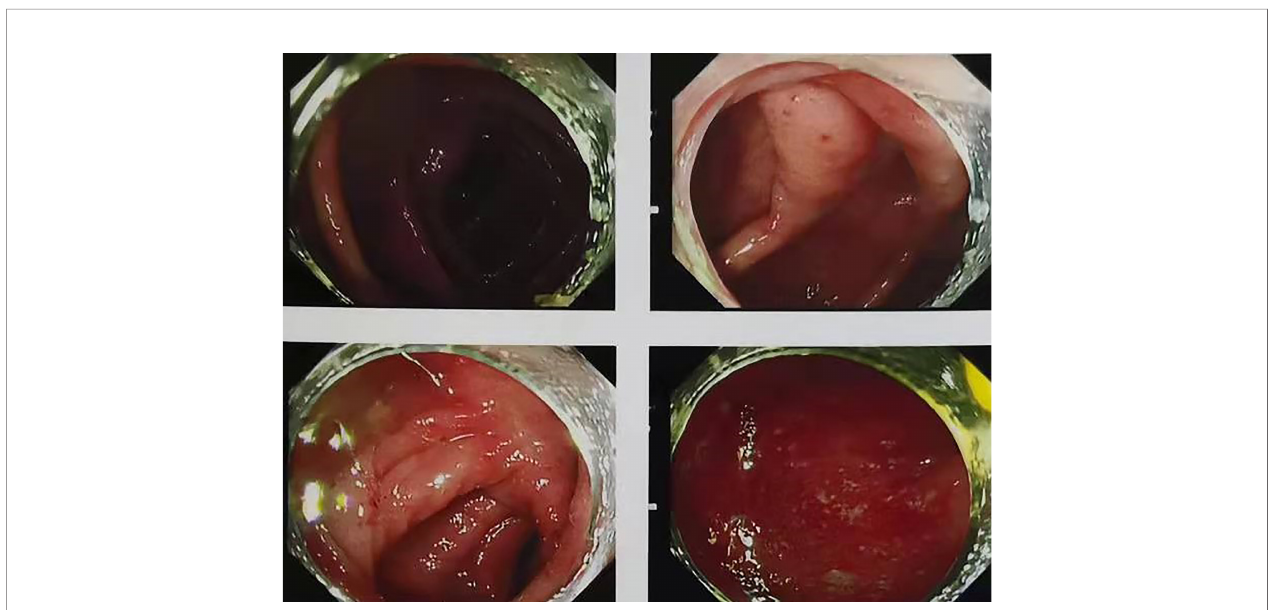
FIGURE 7 | Colonoscopy manifestations following glucocorticoid therapy: scattered and patchy erosions can be seen in the entire colonic mucosa, the rest of the intestinal mucosa is congested and edematous, and the texture of the blood vessels is